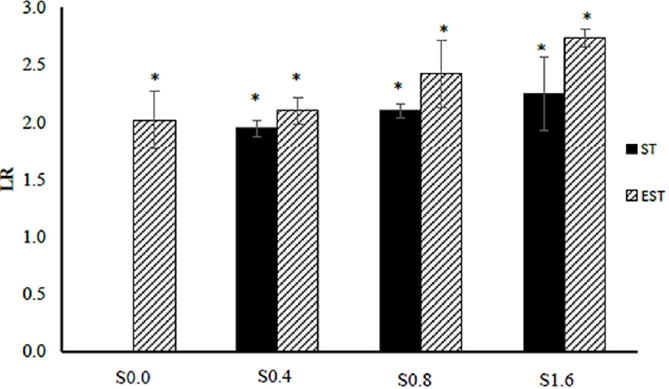
Figure 2. Logarithmic reduction (LR) of E. coli ATCC 25922 after the ionic silver treatments (ST-Sxx) and the electrical-enhanced silver treatments (EST-Sxx) in comparison to the non-ionic and non-electrical treatment (ST-S0.0). The values are expressed as mean ± SD LR ( n = 3); the symbol * indicates a statistically significant difference compared to ST-S0.0 at p < 0.05.